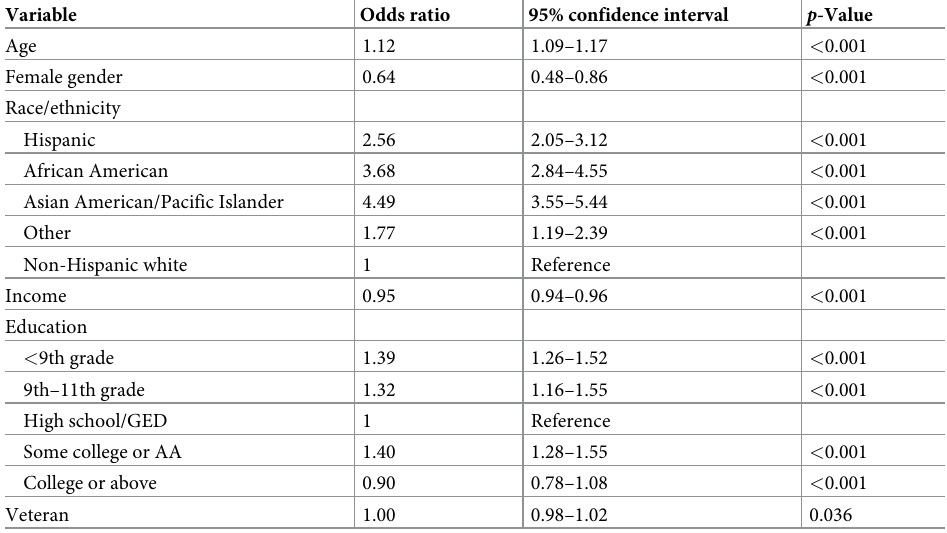
Odds ratios (95% CIs) and p -values from multivariable logistic regression of death from COVID-19. Confidence intervals and p -values may appear incongruent due to